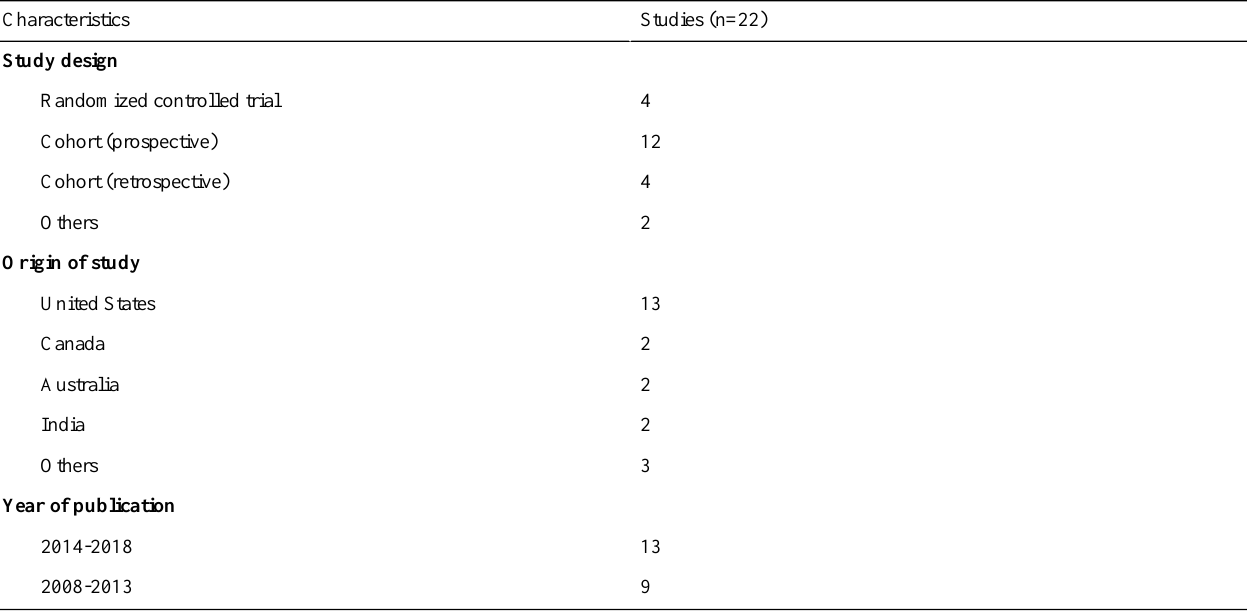
Table 1. General characteristics of the included studies.